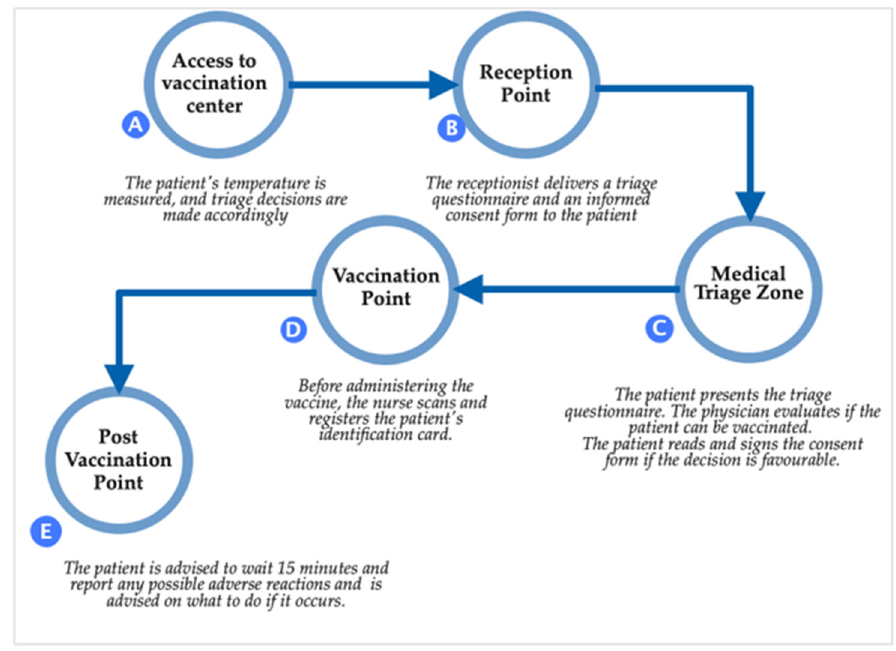
Figure 1. Patient traffic flow.